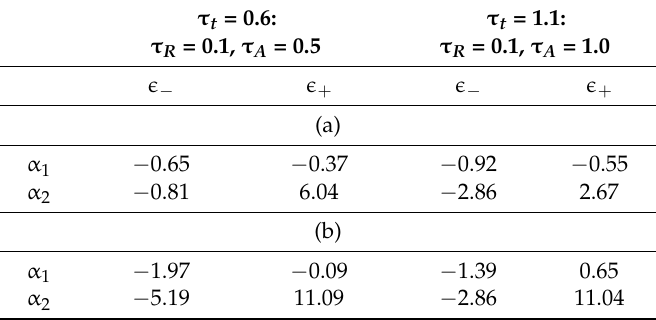
Table 4. Relative confidence intervals, Equation (15), of the retrieved parameters of MODIS BRDF, Equation (14), retrieved from surface radiance using 10 sets of 60 (a), and 10 sets of 12 (b) randomly selected sun-to-sensor geometries for different optical thickness of the